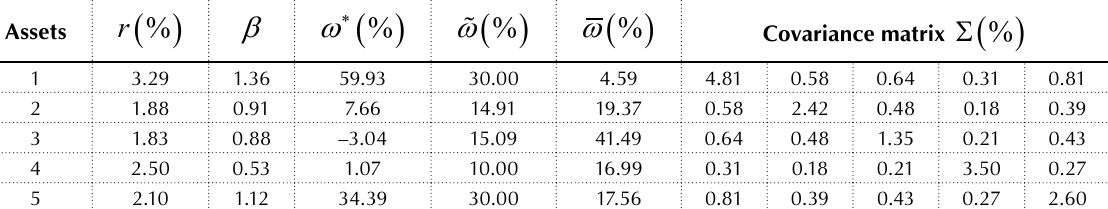
Table 4. Solutions for the unconstrained EIT problem, , ω ∗ for the constrained EIT problem with